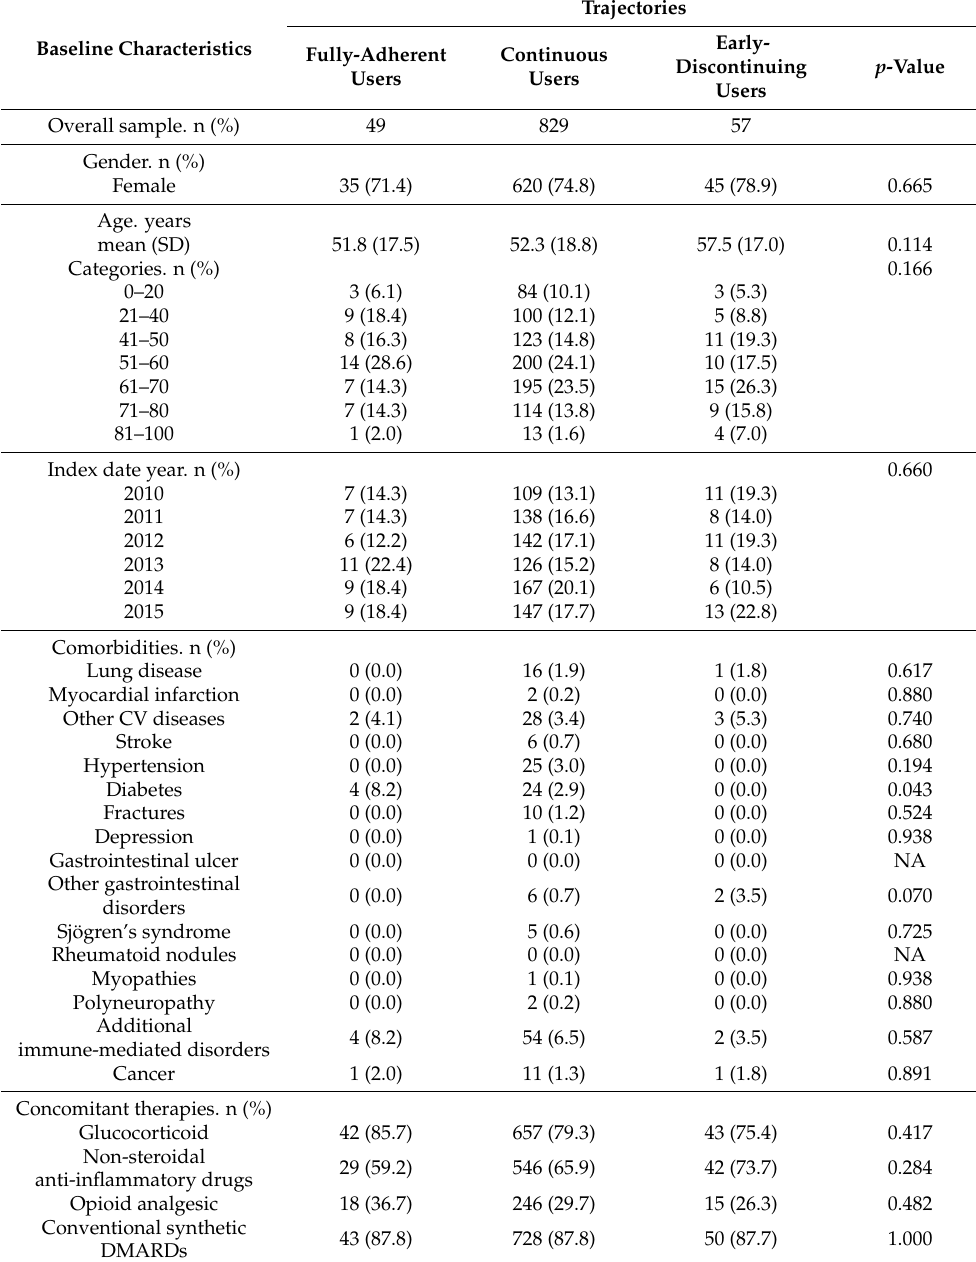
Table 2. Distribution of baseline characteristics of 935 new users of biologic DMARDs in the first- phase